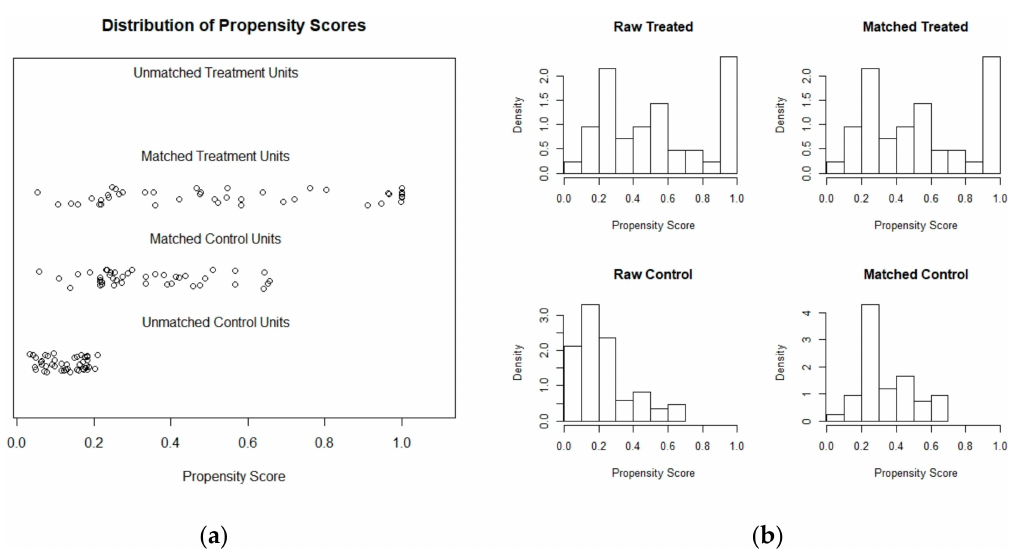
Figure 2. PSM results showing matched treated (REDD + ) and unmatched control municipalities or units ( a ) and distributions of raw and matched treated and control units or municipalities ( b